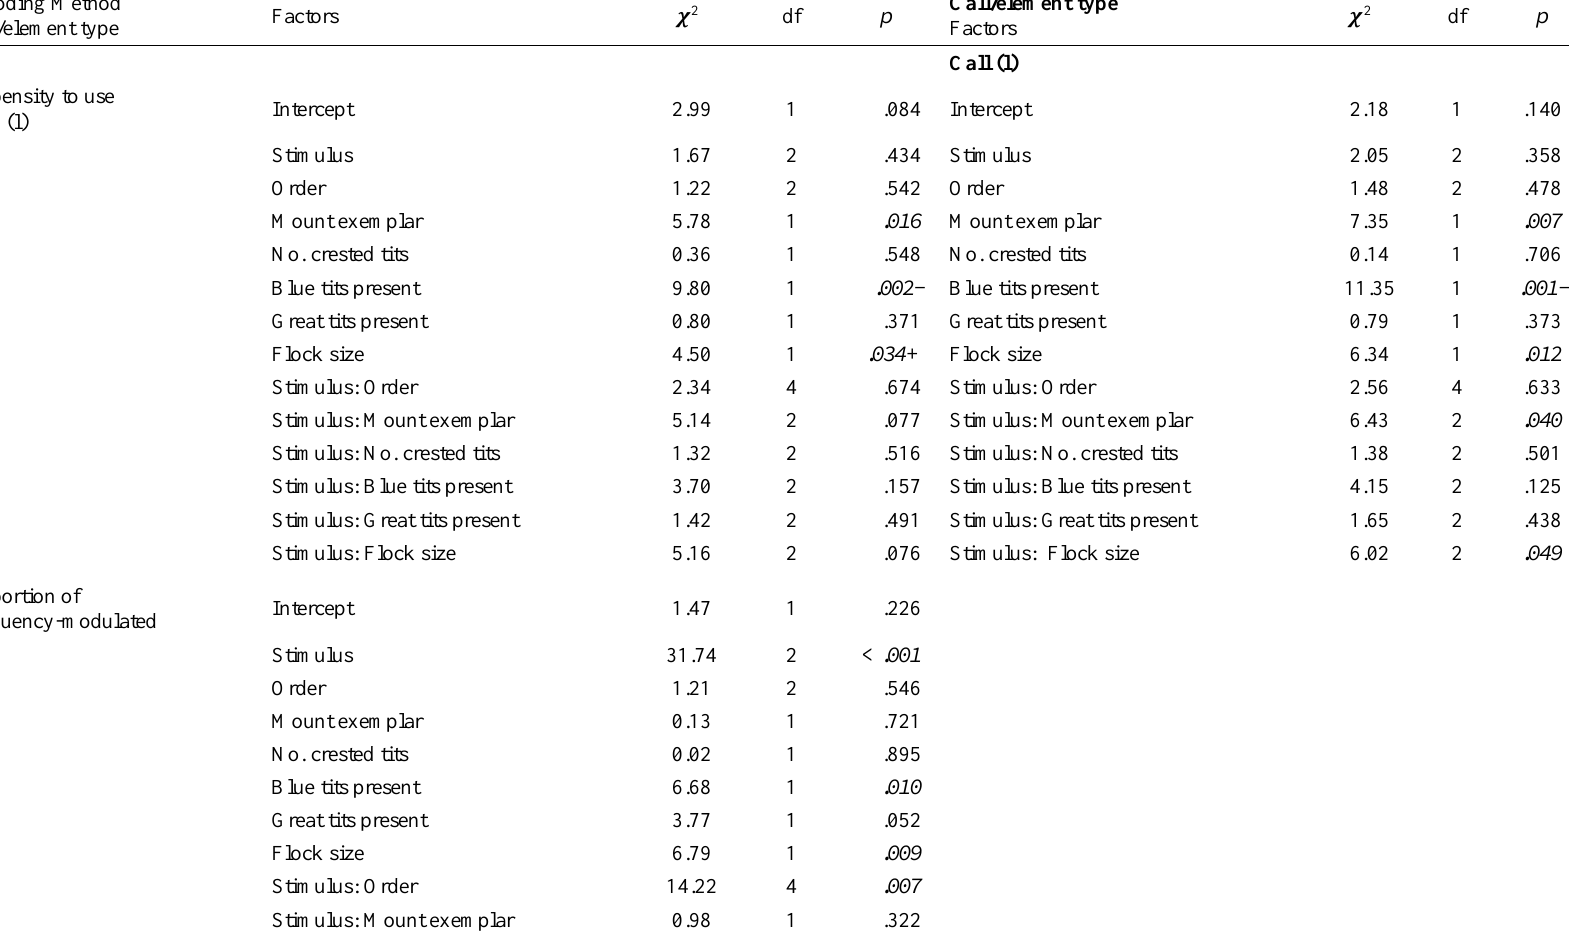
Test Results for Generalized and Linear Mixed Models Testing for Predator Type, Group Size (Conspecific and Flock Size) and Composition (Presence of Blue, Great, and Coal Tits) on Ways of Encoding Information About Predator Threat for Crested Tits. L Indicates that Data was Log (L) Transformed if Residuals were not Normal for Linear Mixed Models. Bonferroni Corrected P-Values Based on the Number of Models are .017. In the Case of Significant Lower Order Effects Without Higher Order Interactions, + and – to the Right of the P-Value Indicate Whether the Effect is Positive or Negative,